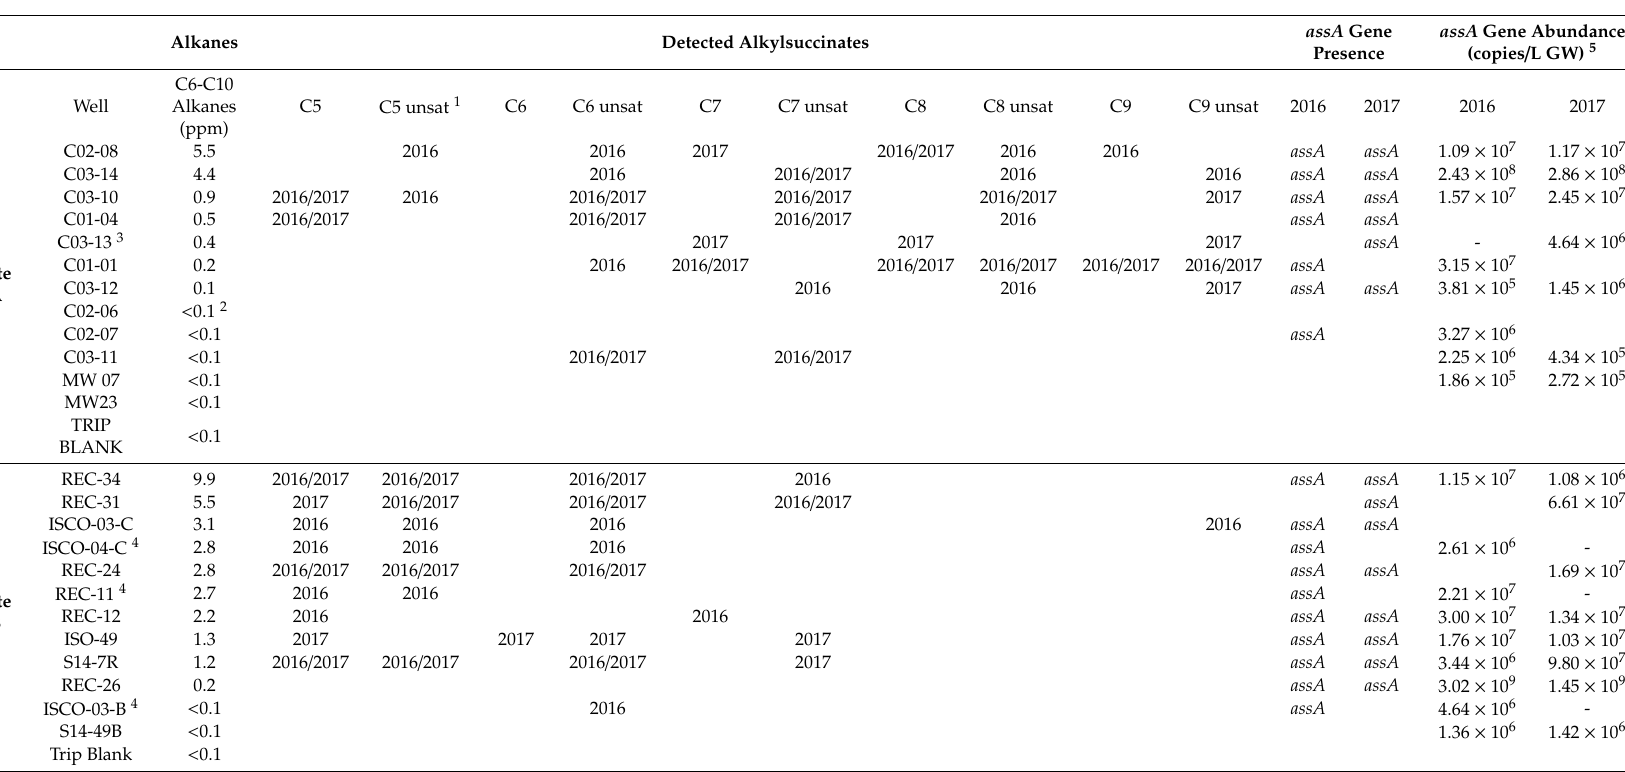
Table 2. Detection of alkane / cyclic alkane-derived fumarate addition metabolites and assA genes (qualitatively and quantitatively determined) in Site A and B groundwater wells sampled in 2016 and 2017. “2016” or “2017” indicates that the metabolite was detected in that year, while “ assA ” denotes gene detection. A blank space denotes absence of metabolite or